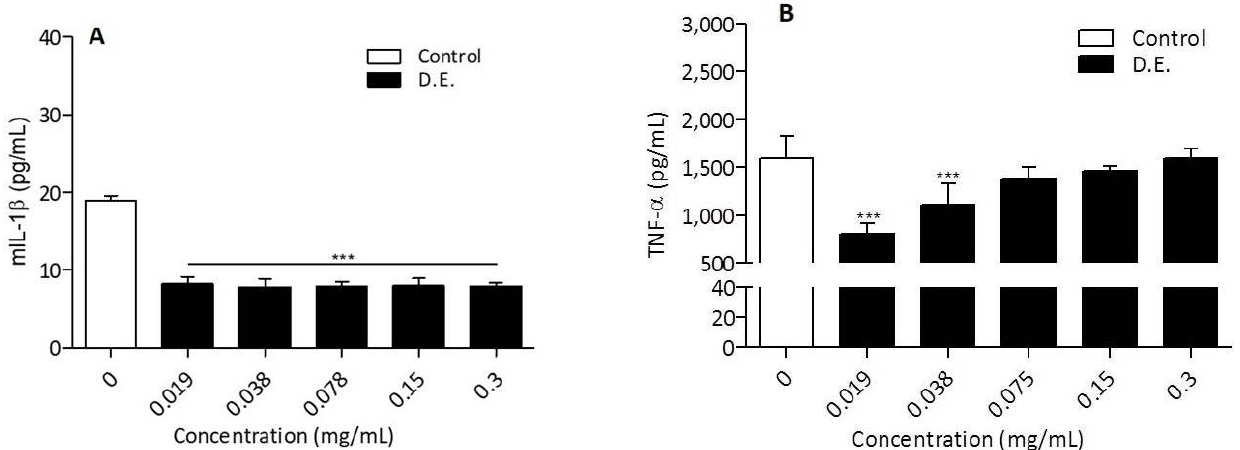
Figure 8. RAW 264.7 cells were in vitro co-treated with LPS (Control) and different concentrations of extract D.E. for 24 h. IL-1β ( A ) and TNF-α ( B ) concentrations in the culture supernatants were determined by ELISA test. *** p < 0.0001, D.E. vs. Control (One-way ANOVA test). Results are reported as the mean of 2 independent experiments, each conducted in triplicate.